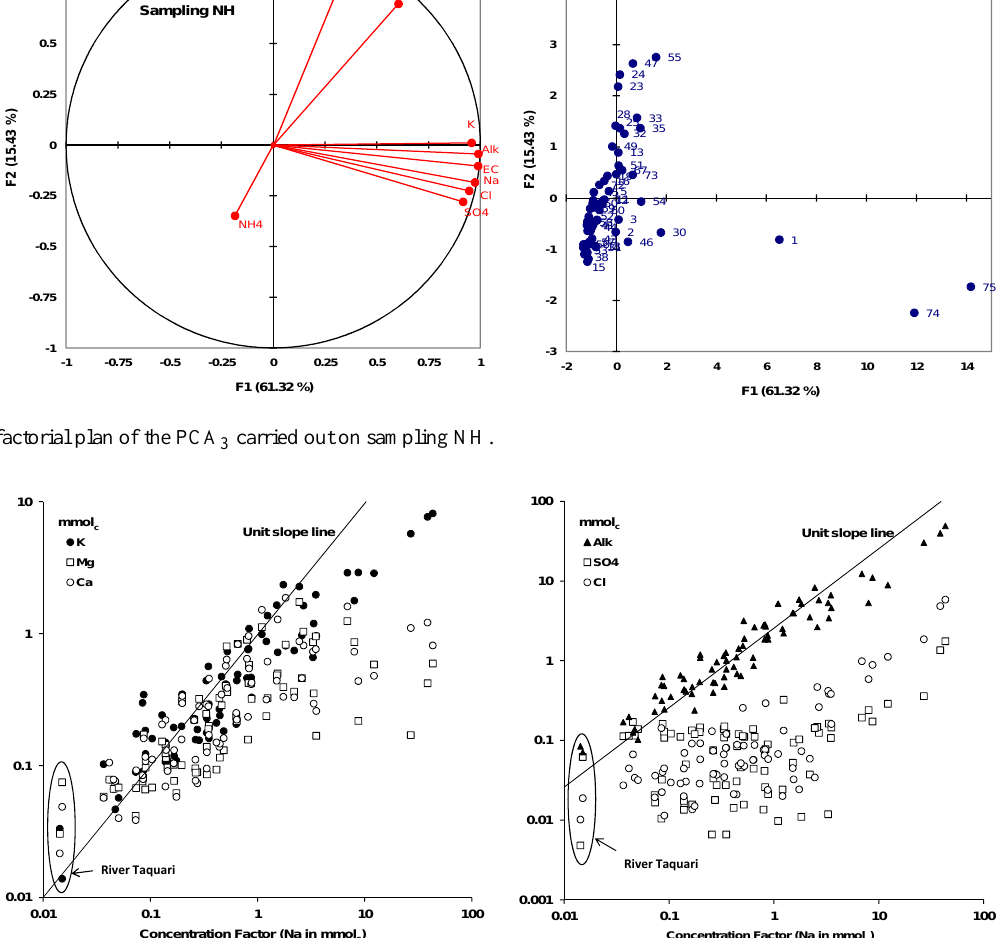
Fig. 12. Concentration diagrams for major elements of sampling NH and river Taquari (sample 37 from samplings DS and WS).